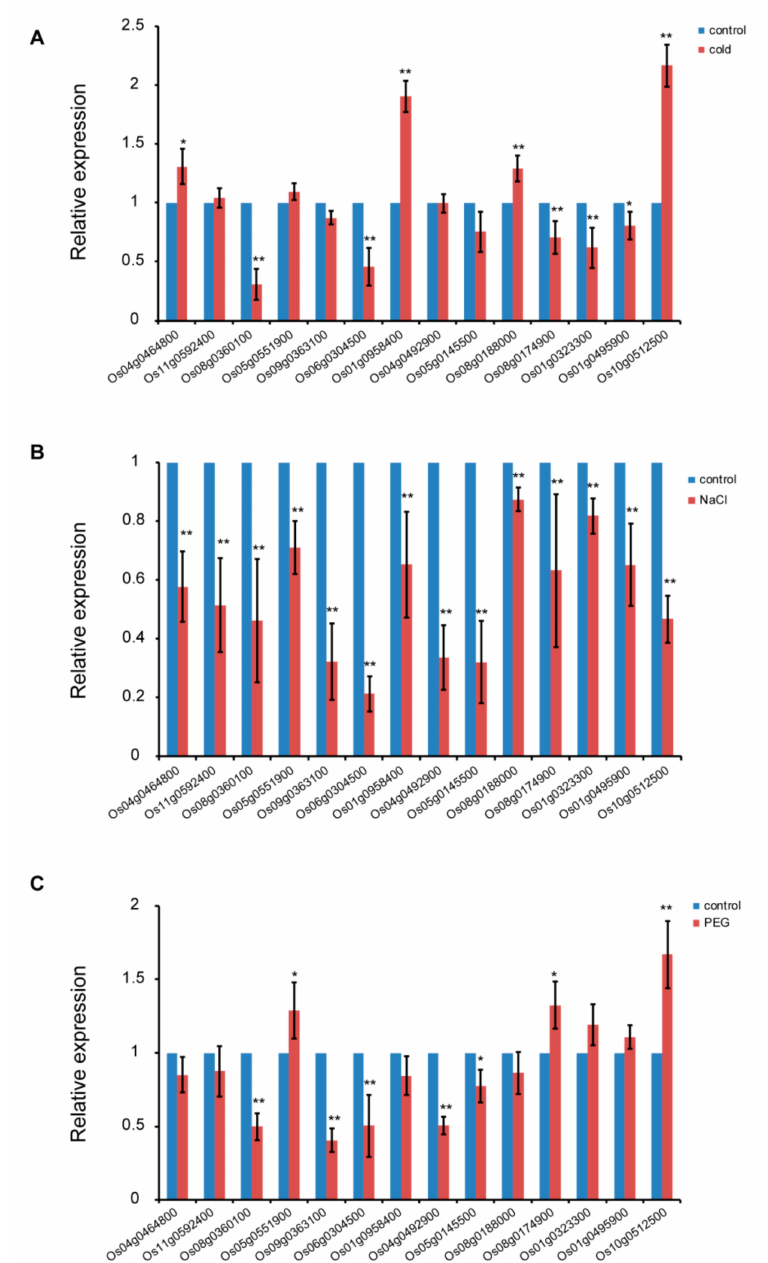
Figure 5. Analysis of CRM gene expression in the leaves of three-leaf stages under ( A ) cold stress (15 ◦ C), ( B ) salt stress (100mM NaCl), and ( C ) drought stress (10% PEG). Data are the mean ± SD for three biological replicates. * p < 0.05, ** p < 0.01 by Student’s